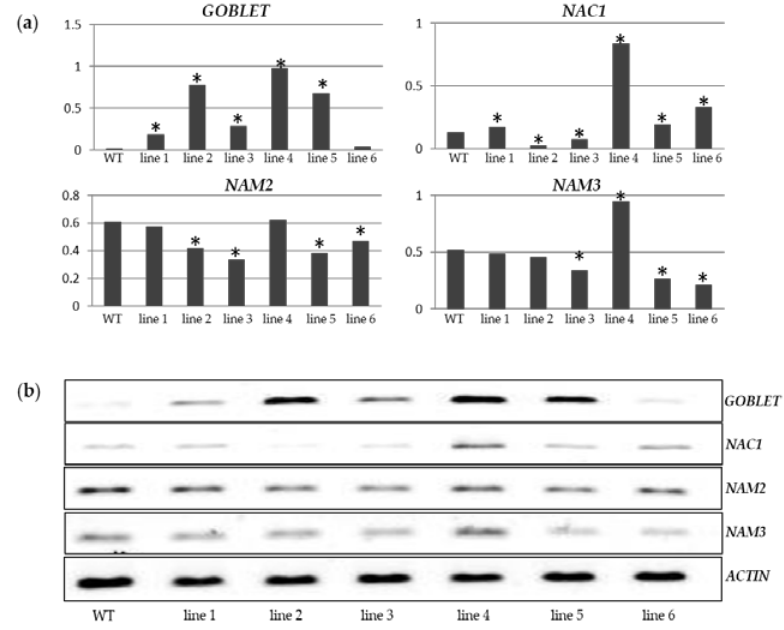
Figure 7. Expression analyses of miR164 target genes in 164-OE tomato plants. ( a ) Relative expression of miR164 target genes based on RT-PCR data; ( b ) RT-PCR of miR164 target genes in 164-OE tomato plants. Flower tissue of the different lines with constitutive miR164 expression was used. * indicates that there is a statistically significant difference.